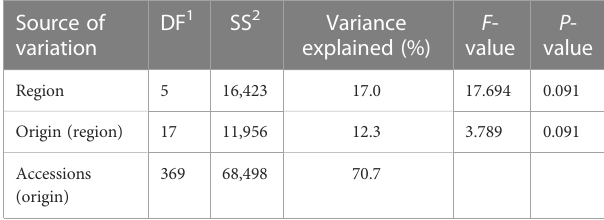
TABLE 2 Permutational multivariate analysis of variance of 392 red clover accessions from 24 countries and six regions genotyped using 20,137 SNPs.